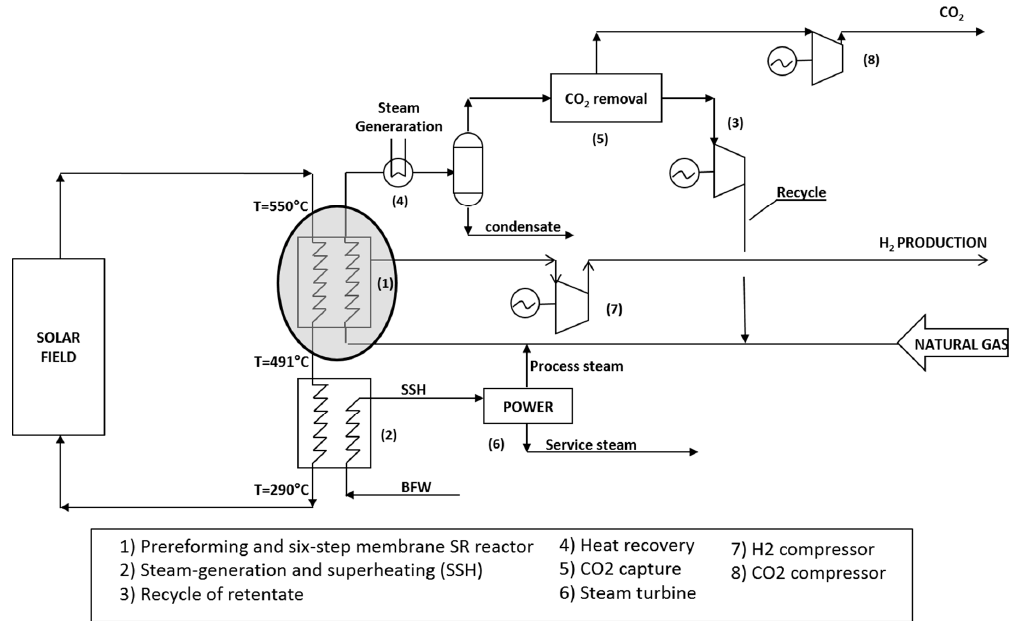
Figure 11. Process scheme for membrane steam reforming solar energy assisted with export power production.